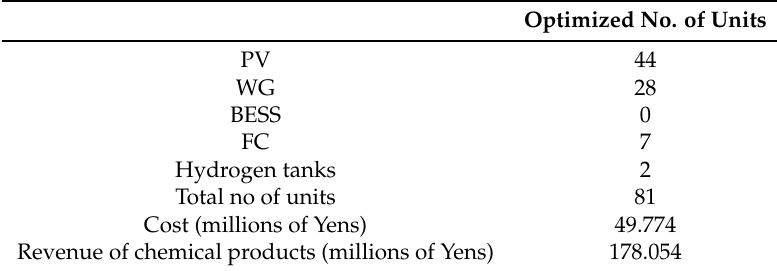
Table 4. Scenario 3 results.